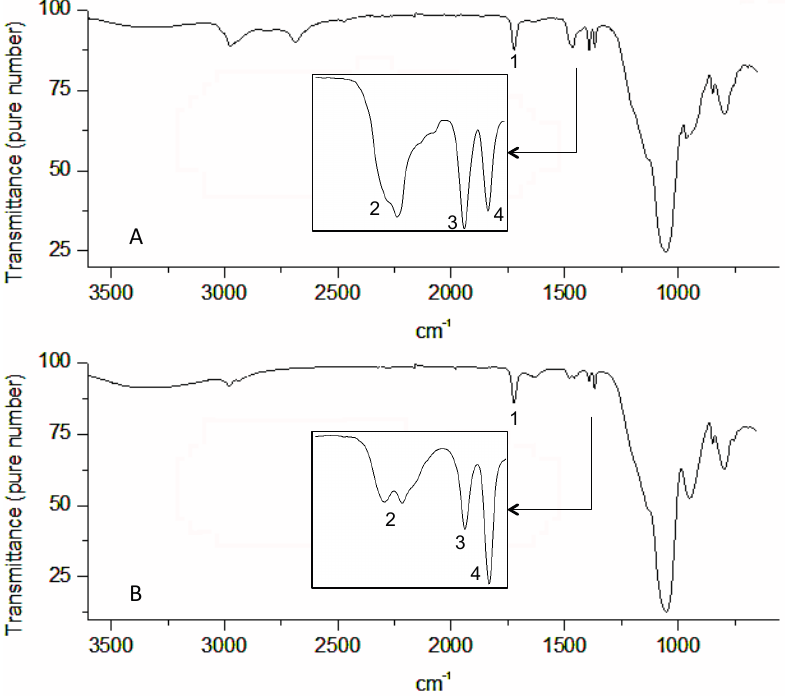
Figure 4. Attenuated total reflectance IR (ATR-IR) spectra of PBMA decorated Si-NP before ( A ) and after de-protection ( B ) with aqueous phosphoric